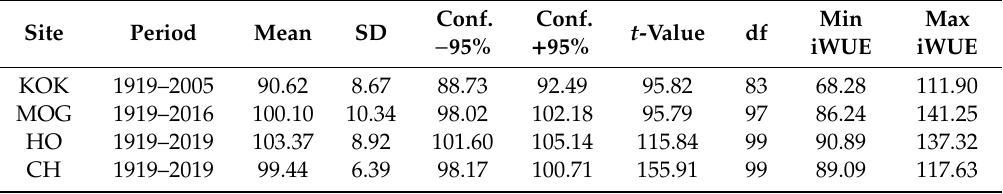
Table 2. Statistical parameters of iWUE given as mean, standard deviation (SD), t -value to test di ff erence between study sites, degree of freedom ( df ), minimum (min) and maximum (max), calculated for the Koksu (KOK), Mongun (MOG), Ersin (HO), and Chadan (CH) study sites.